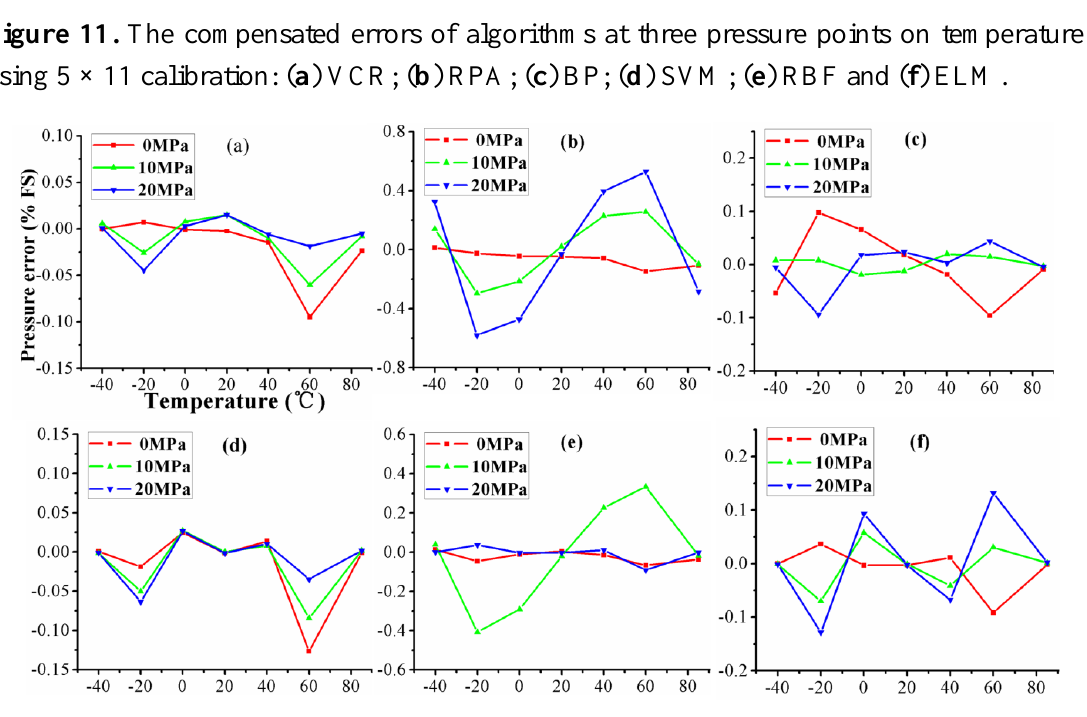
Figure 11. The compensated errors of algorithms at three pressure points on temperature